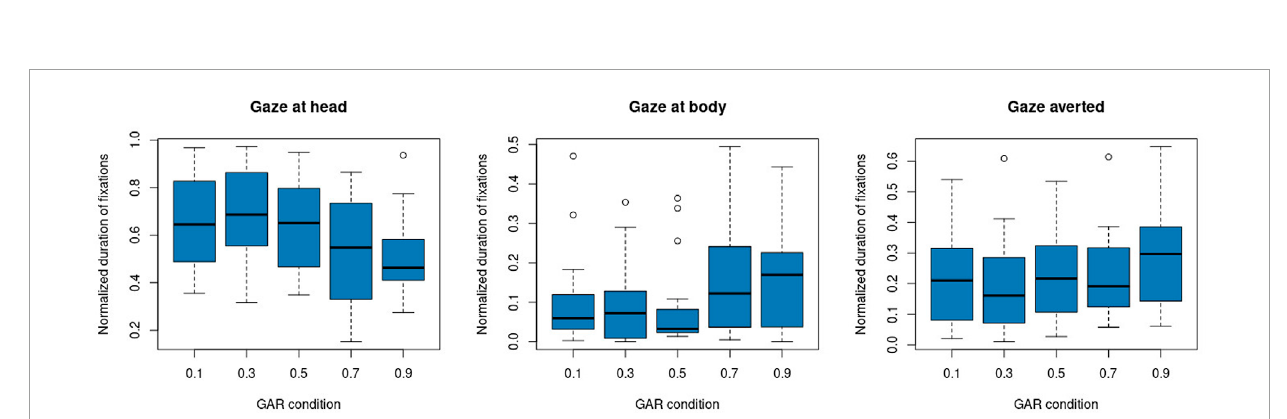
FIGURE 4 Normalized gaze duration on ROIs, head, body, gaze averted, for each GAR